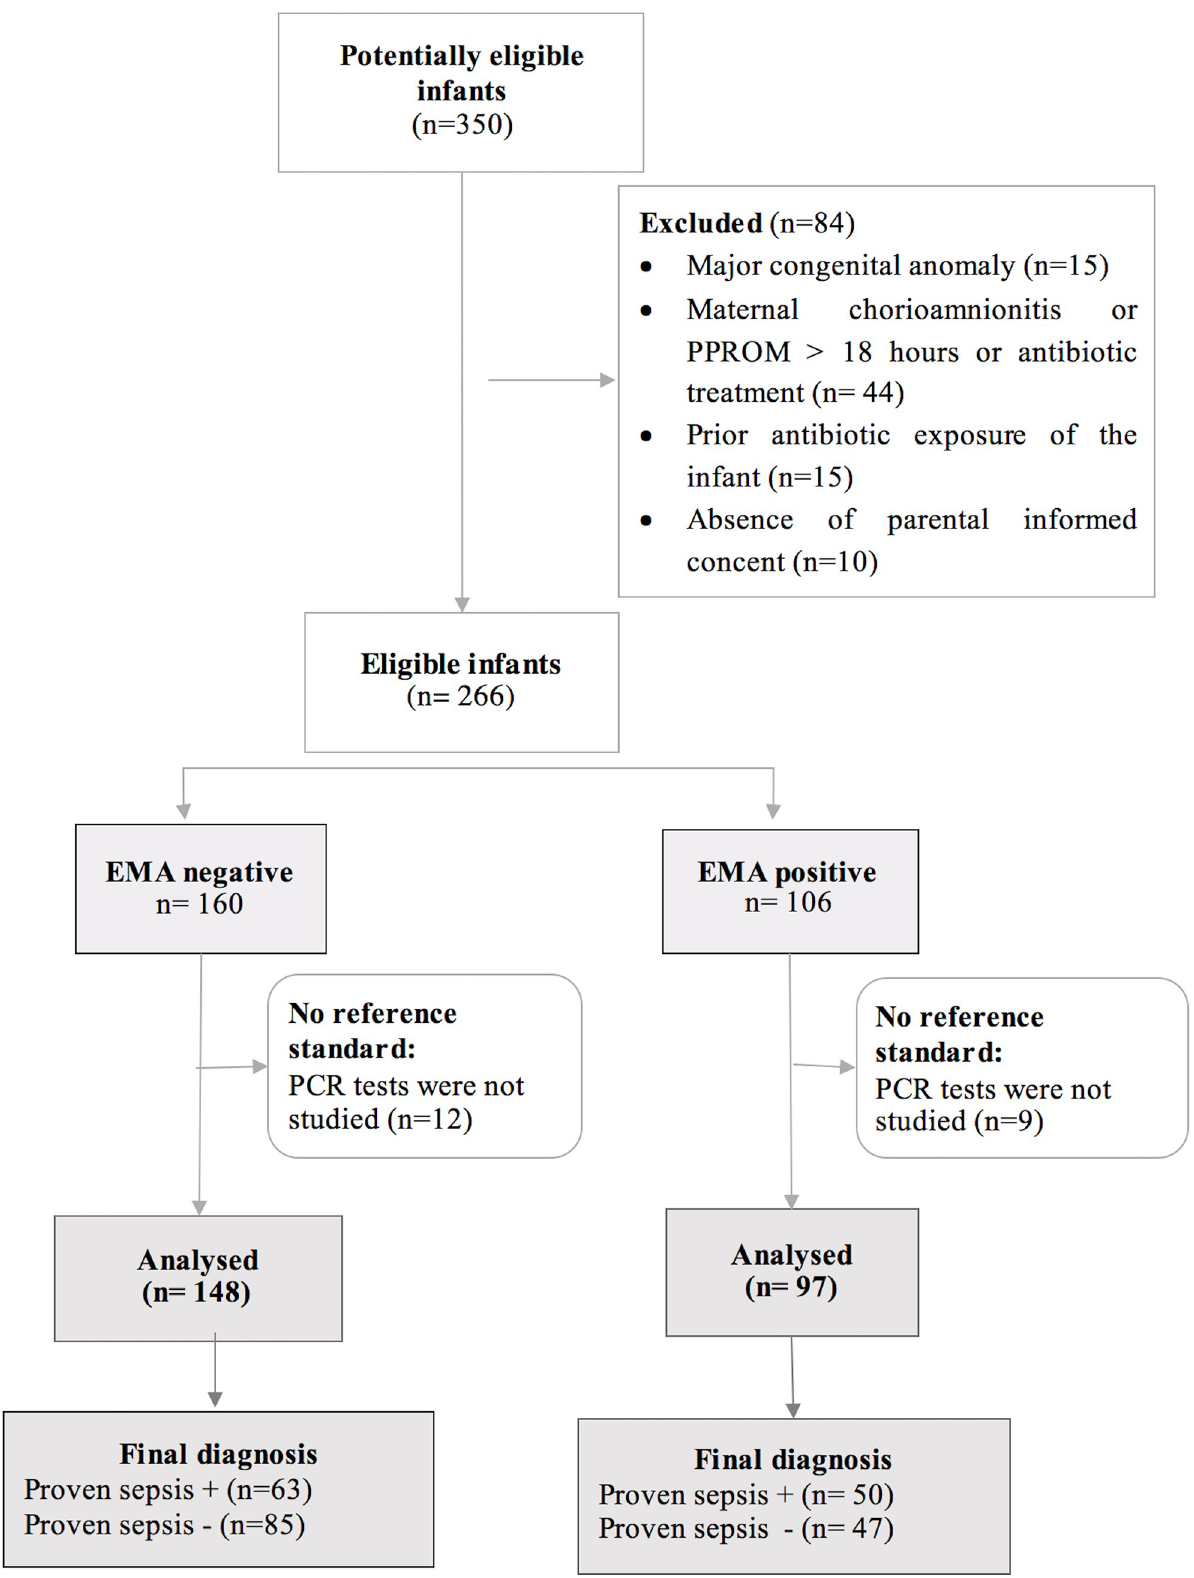
Fig 1. Flow diagram of the patients. 245 infants were included to the study among 350 potentially eligible infants.